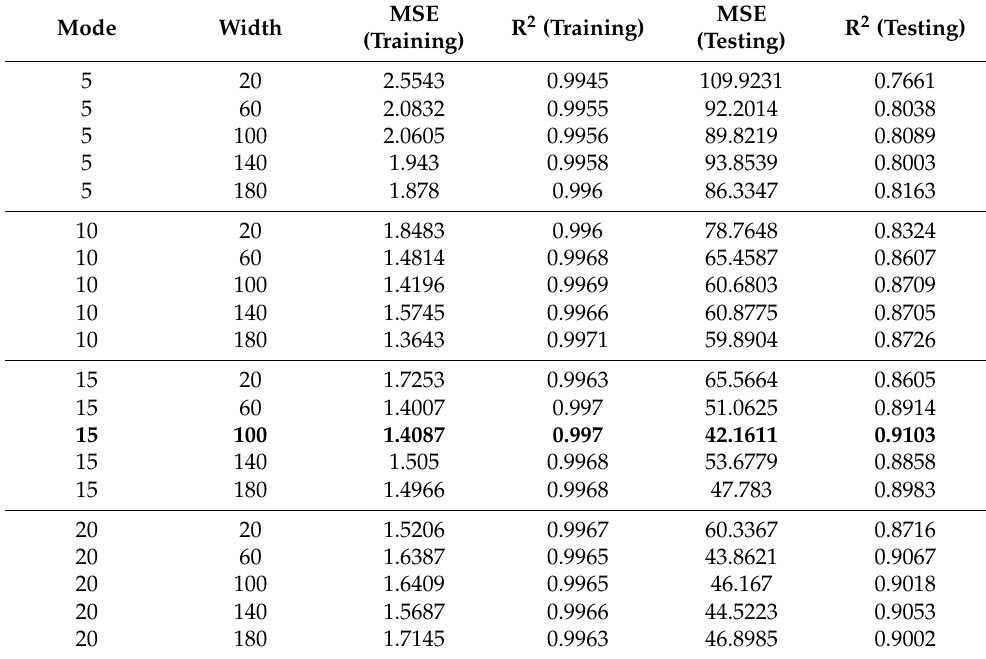
Table 1. Performance of the developed FNO models with different modes and widths based on MSE and R 2